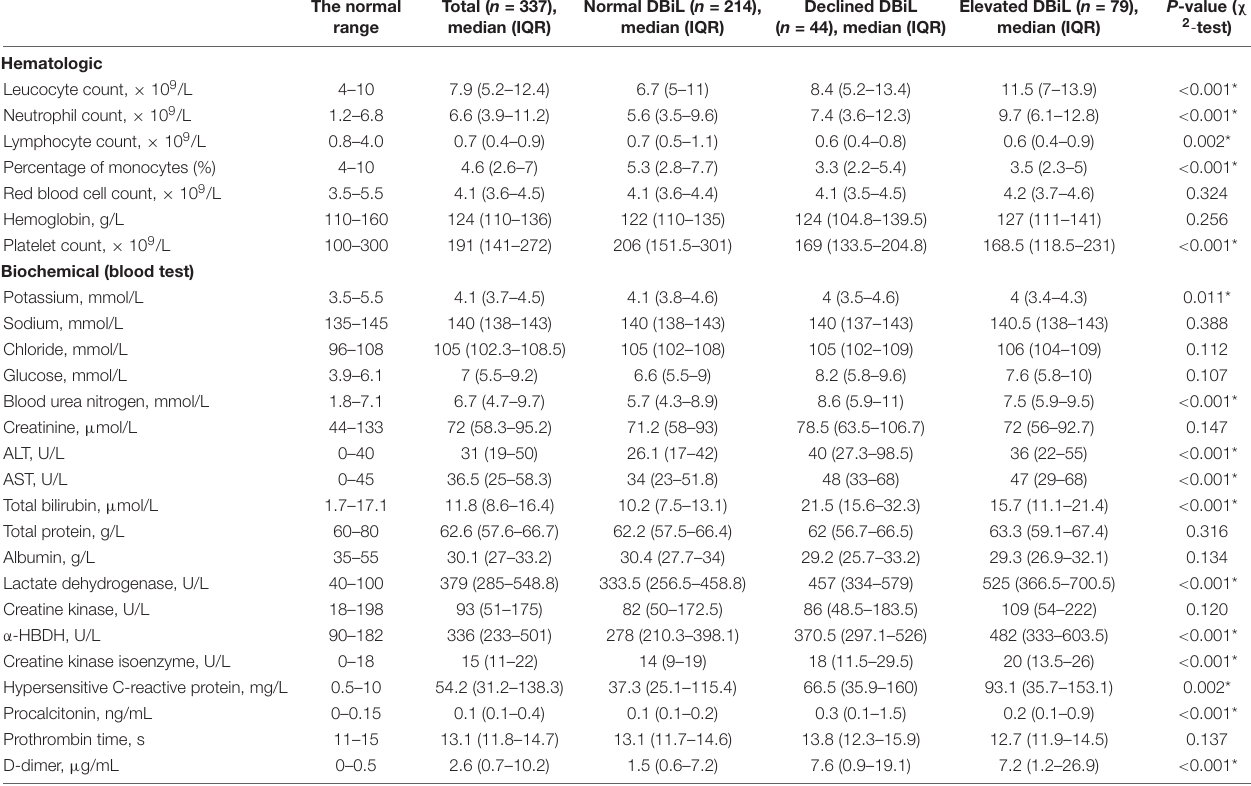
TABLE 2 | Basic laboratory results of 337 COVID-19 severe/critically ill patients. The normal